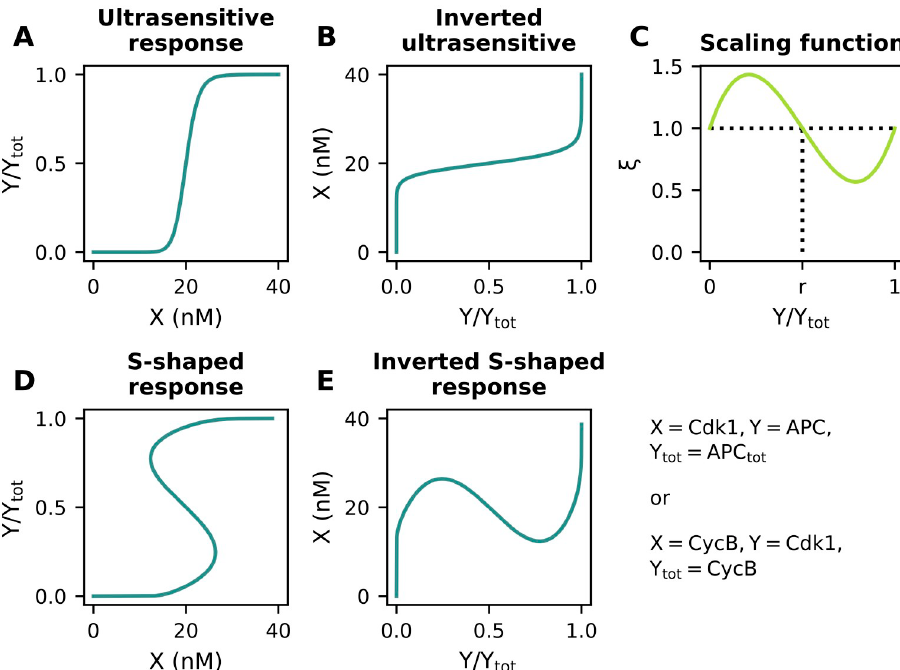
Fig 9. An ultrasensitive response curve of variable Y normalized for its total concentration Y tot (A) can be converted into an S-shaped one (D) by inverting the product (E) of a scaling function (C) with the inverted ultrasensitive response